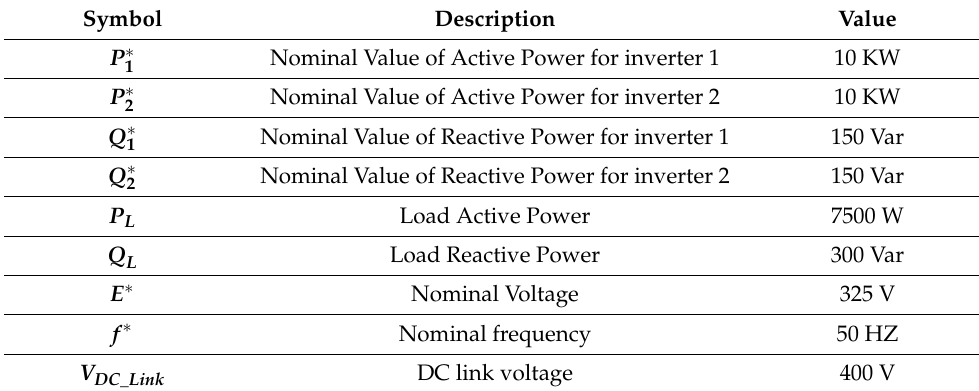
Figure 12. Small signal model for the power control system of different algorithms and droop controller by ( a ) conventional PID ( b ) PSO algorithm, ( c ) ABC algorithm, and ( d ) H ∞ controller with ABC algorithm. Table 2. Case study parameters.